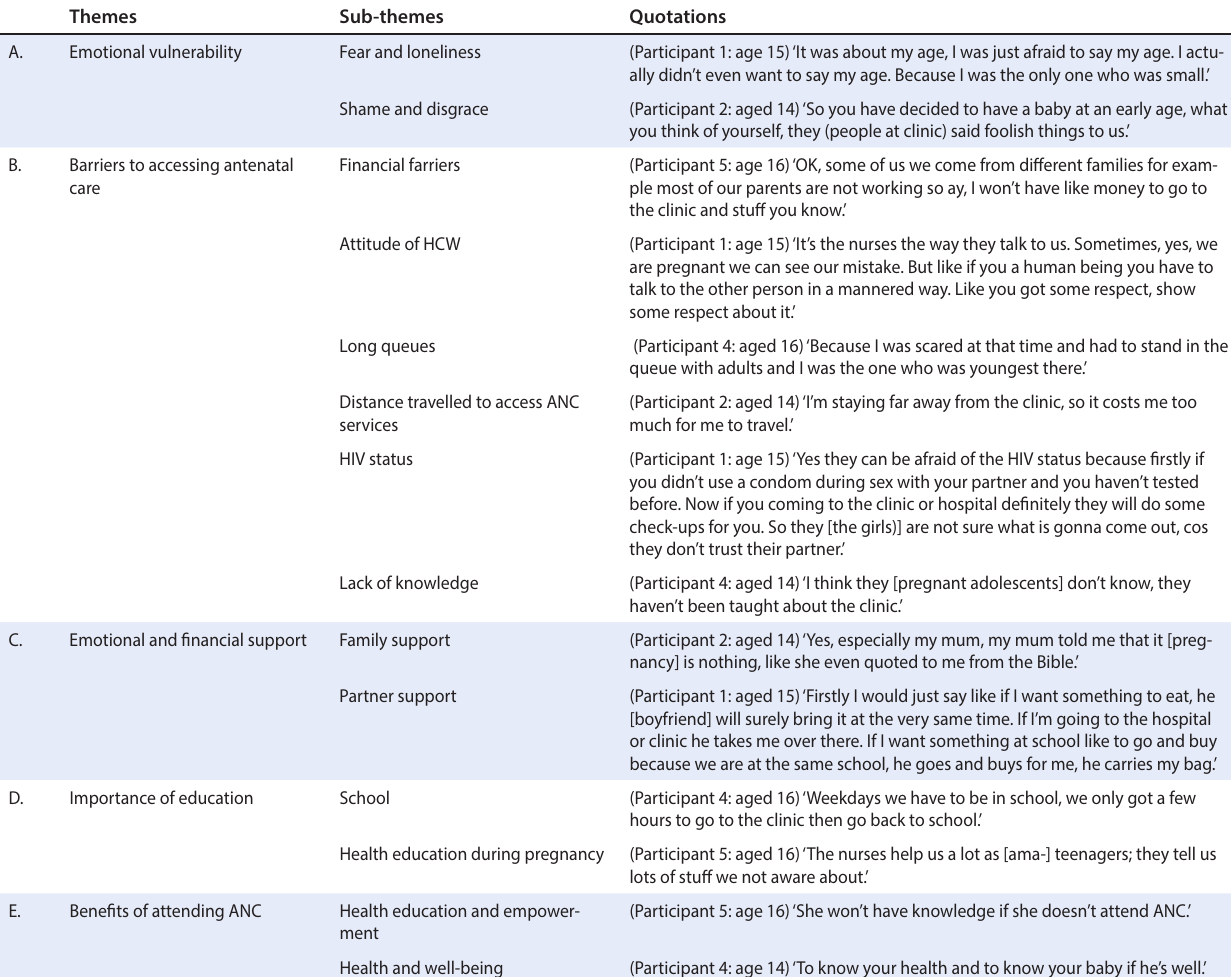
Table 4: Qualitative interviews: themes and